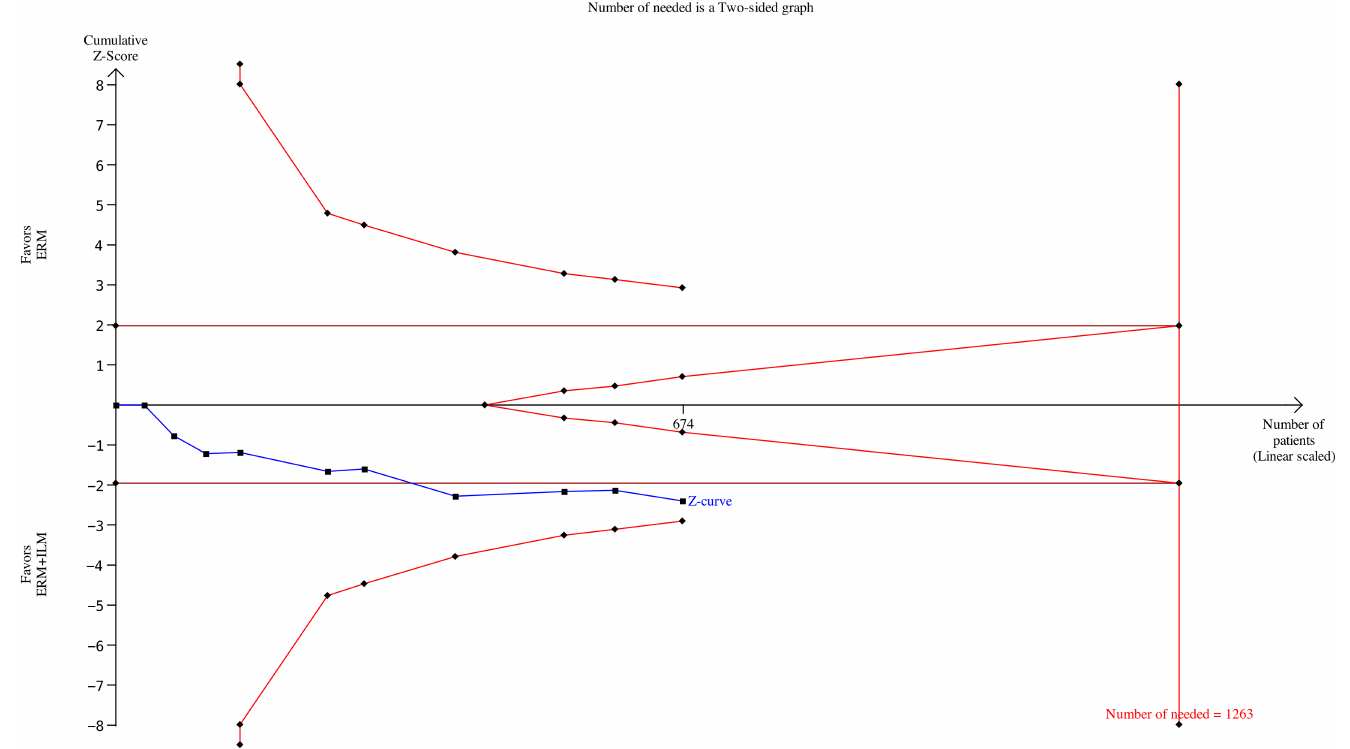
Fig 3. Trial Sequential Analysis (TSA) of the ERM recurrencerate outcome in this meta-analysis. TSA is a methodology that includesa sample size calculationfor a meta-analysis with the thresholdof statistical significance. The detailed settings of this TSA were shown as follows: Significance level = 0.05; Power = 0.80; incidenceof control = 2.3; relativerisk reduction= 30%; I 2 = 0%. Finally, the number of requiredsamples is 1263but this meta- analysiscollectedonly 674 samples.